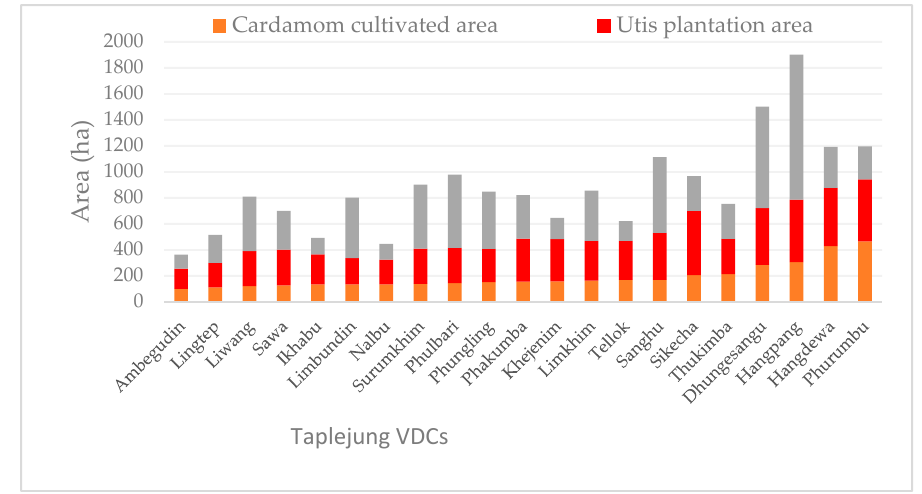
Figure 7. VDC ‐ wise statistics to identify current utilization of the potential habitat. Figure 7. VDC-wise statistics to identify current utilization of the potential